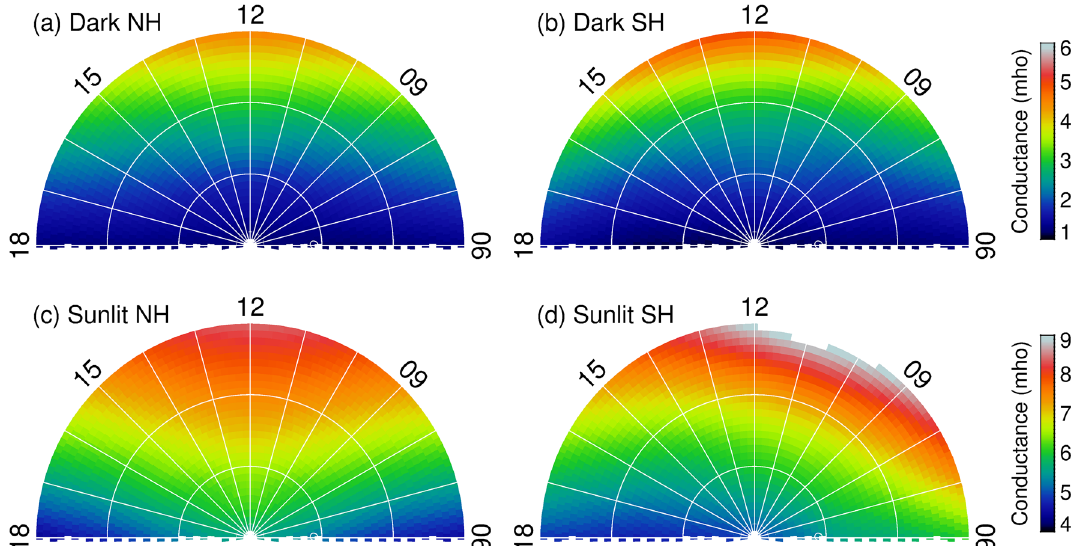
Figure 5. Dayside maps of the Pedersen photo-conductance for ( a ) dark NH, ( b ) dark SH, ( c ) sunlit NH, and ( d ) sunlit SH. The figure is produced by the first author using the Interactive Data Language (IDL) software version 8.2.3. The ULR link for IDL is https ://www.harri sgeos patia